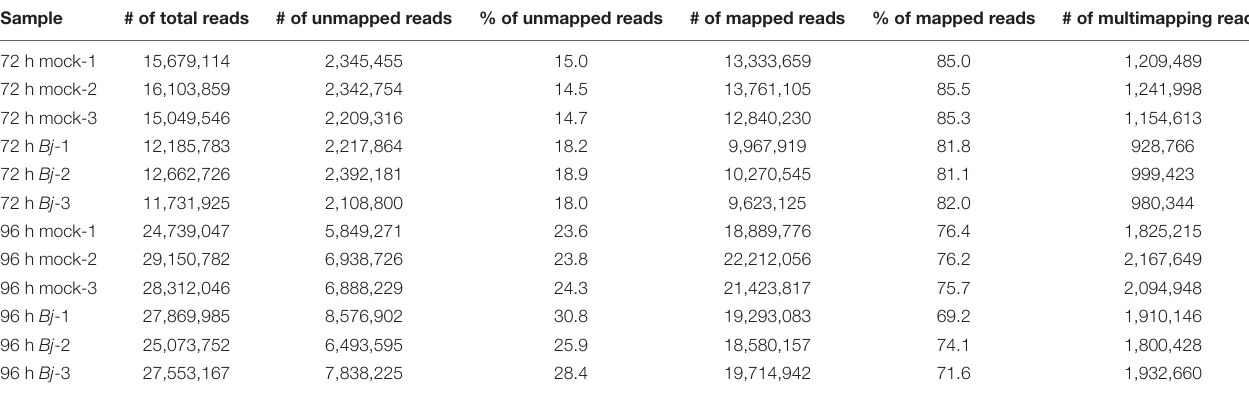
TABLE 1 | Illumina RNA-seq output and mapping of 75-bp reads.